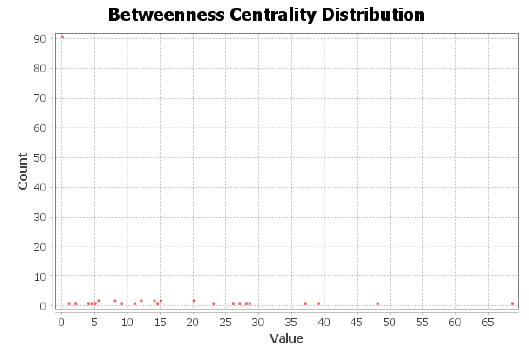
Figure 14. Betweenness Centrality Distribution in Network